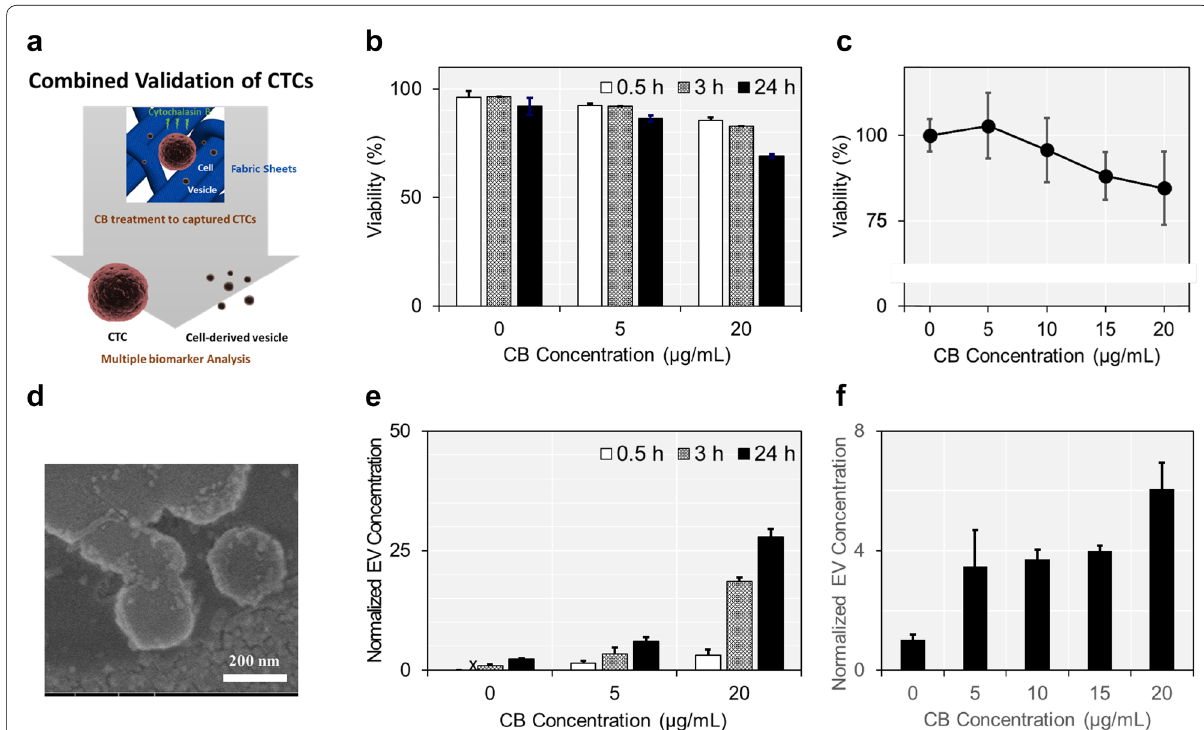
Fig. 1 The effect of CB on cell viability and EV secretion: a precisely controlling the CB concentration and treatment time enabled multi‑modal screening of CTCs. CB treatment promoted cancer cells captured on the fabric filters to secrete large number of EVs with minimal cytotoxic effect. b Viability of CB‑treated cancer cells were measured using two‑colored live/dead assay. c Viability of cancer cells were further quantitatively measured in depth, using Alamar blue viability assay after 3 h‑CB treatment. No significant cytotoxic effects were found at the CB concentration of and treatment time of 3 h. d SEM was utilized to image the EVs secreted from MCF‑7 cancer cells. e , f CB treatment significantly enhanced the EV ≤ secretion. CB increased EV secretion by 3.5‑fold at the concentration of 5 μg/mL and there was no further significant increment in EV concentration until it reached 20